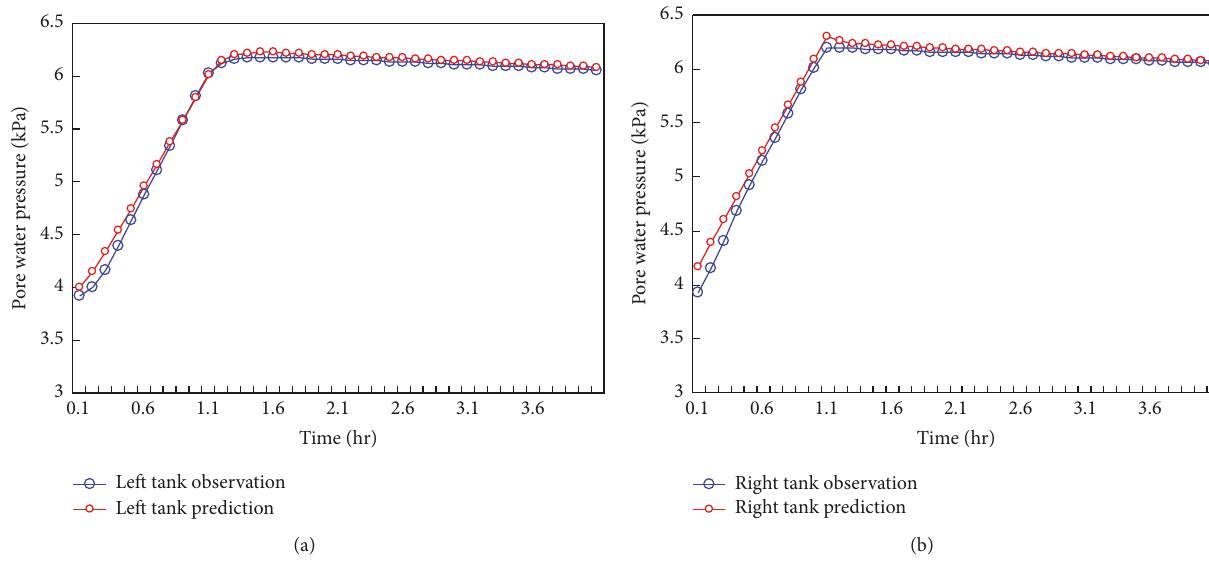
Figure 15: Prediction by modified tank model (coarse material): (a) left tank and (b) right